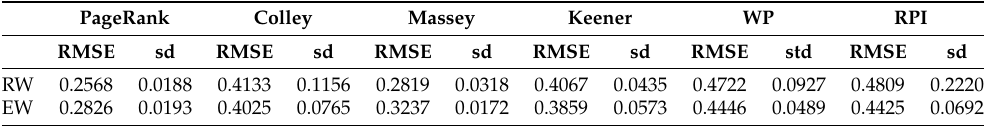
Table 3. Average rating error for rolling and expanding window